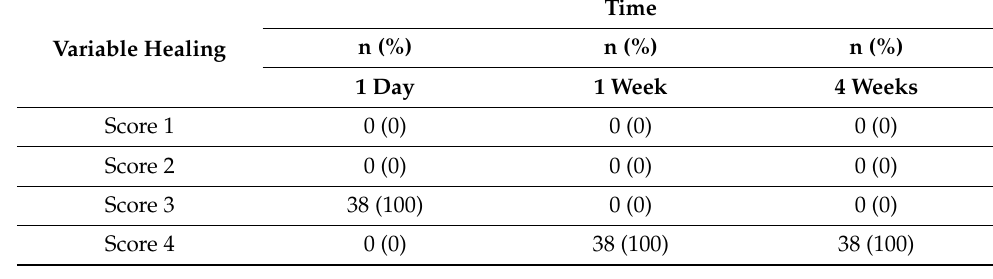
Table 4. Healing at day 1, week 1 and 4 after treatment.